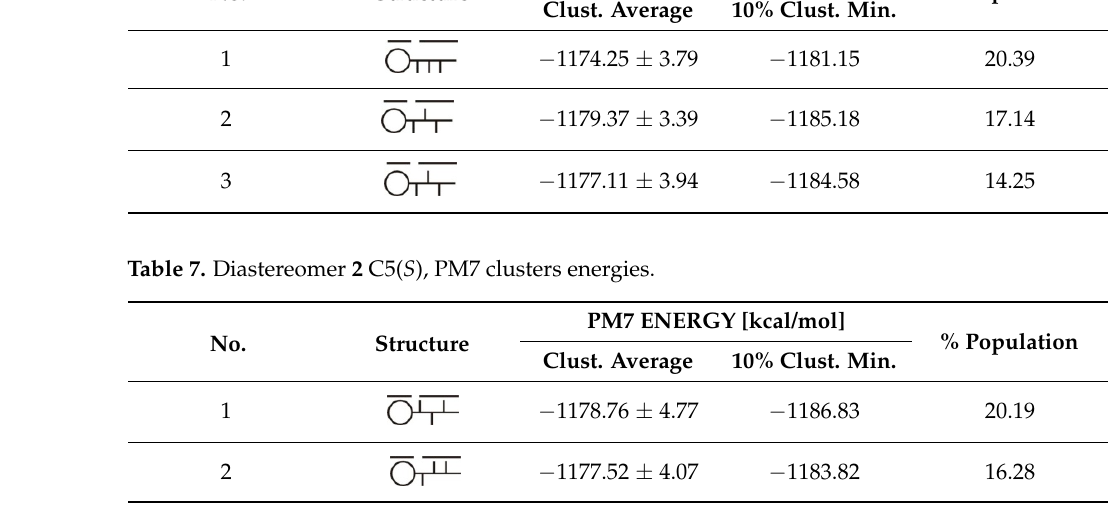
Table 6. Diastereomer 1 C5( R ), PM7 most populated cluster energies.